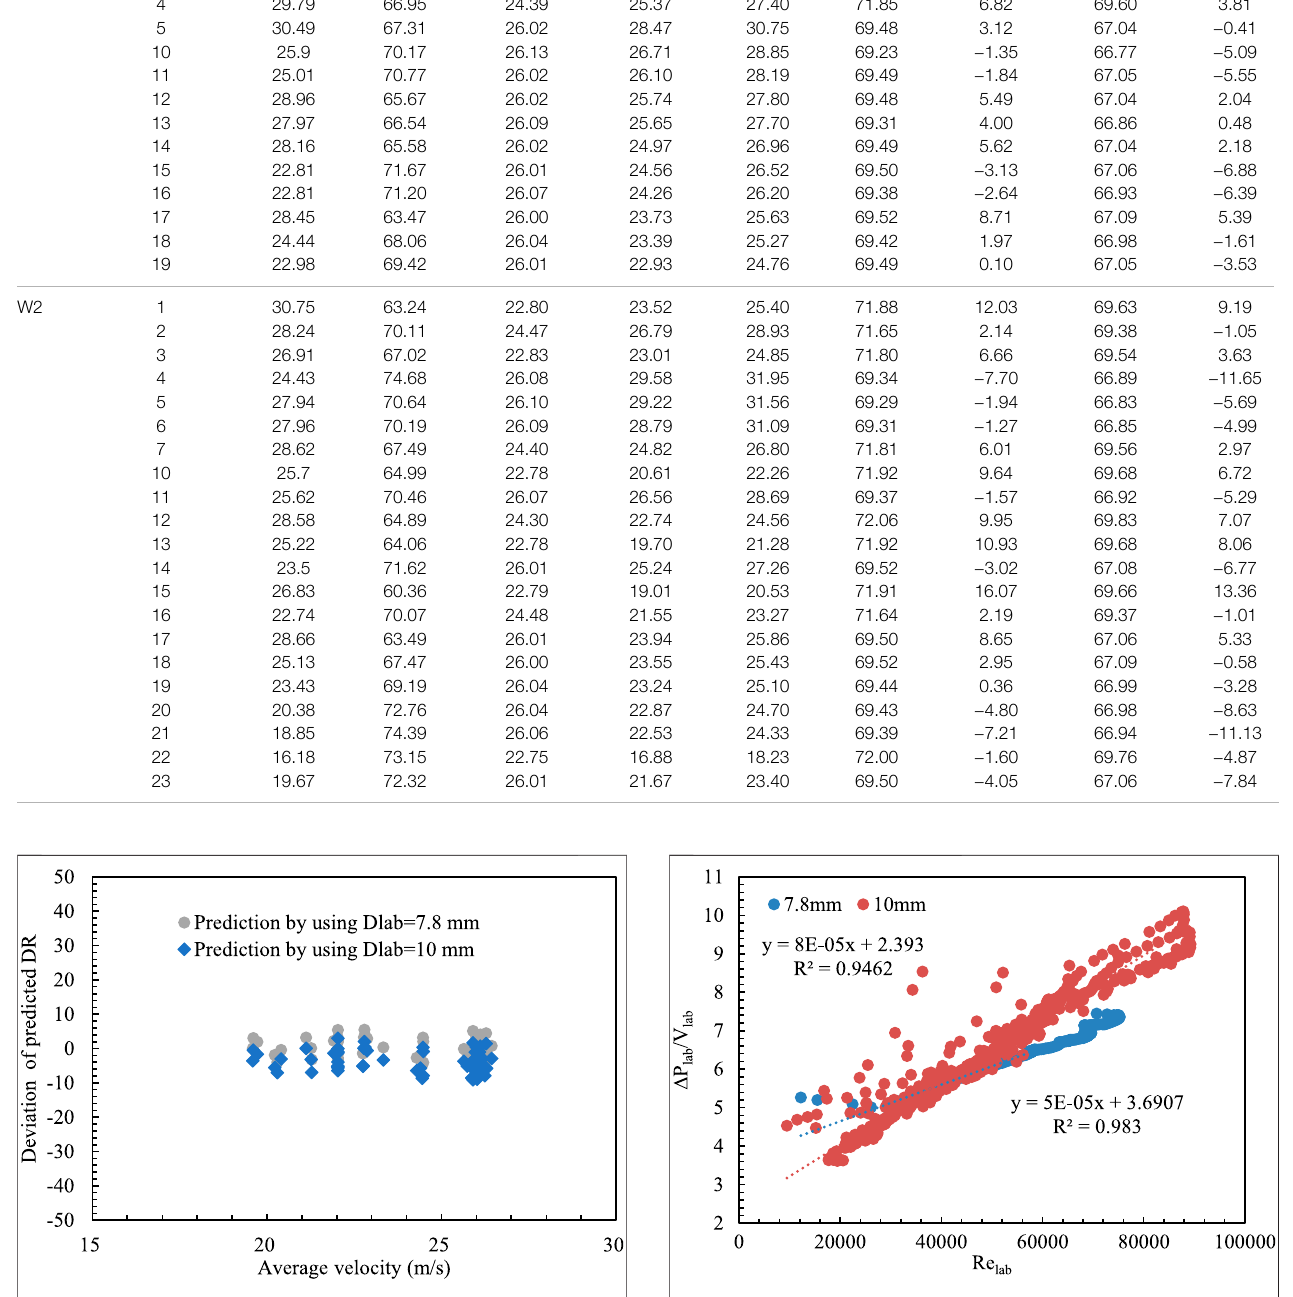
FIGURE 4 | DR prediction deviations at different D lab . FIGURE 5 | Relationship between Δ P lab /V lab and Re lab